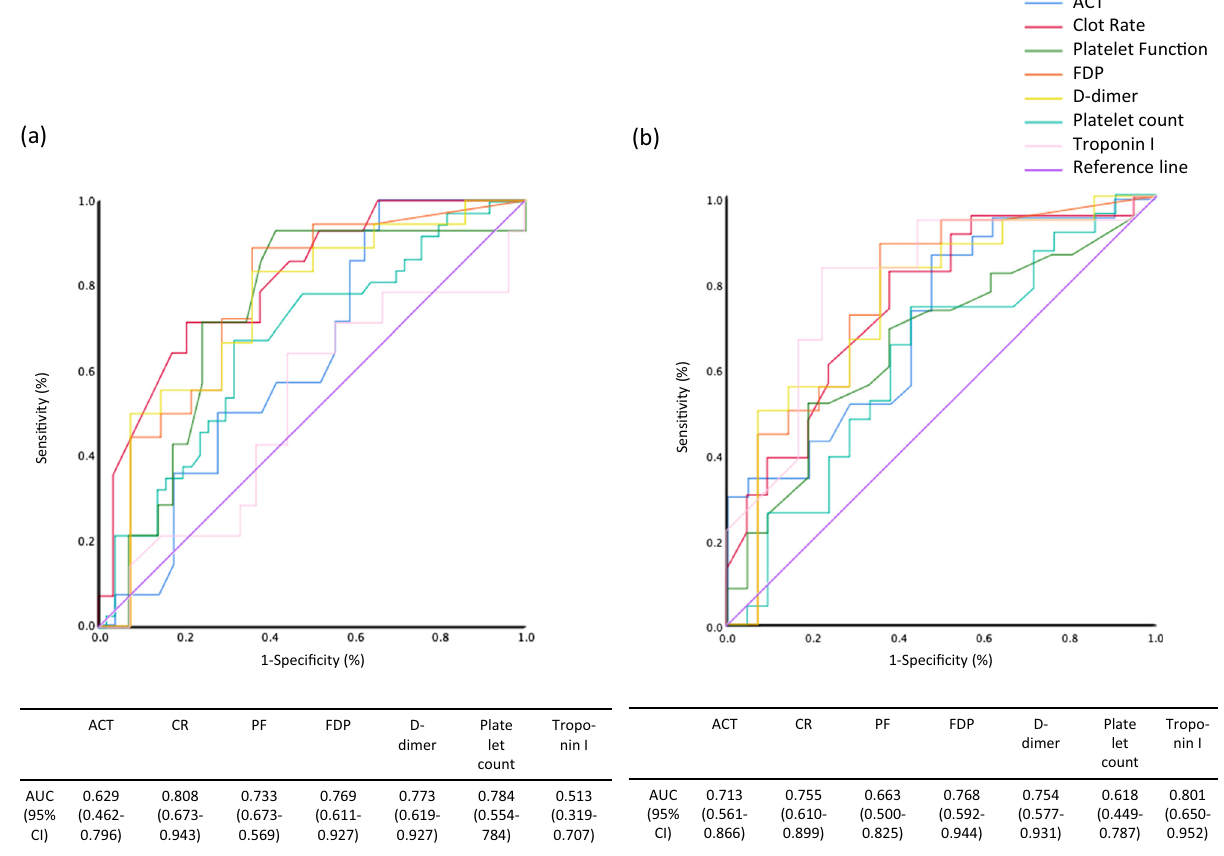
Figure 2: The ROC curves and AUCs of ACT, CR, PF, FDP level, D - dimer level, platelet count, and troponin I level for ROSC in patients with OHCA due to cardiac ( a ) or non - cardiac causes ( b ) . The ACT, CR, and PF were measured by the Sonoclot analyzer. 95% CI, con fi dence